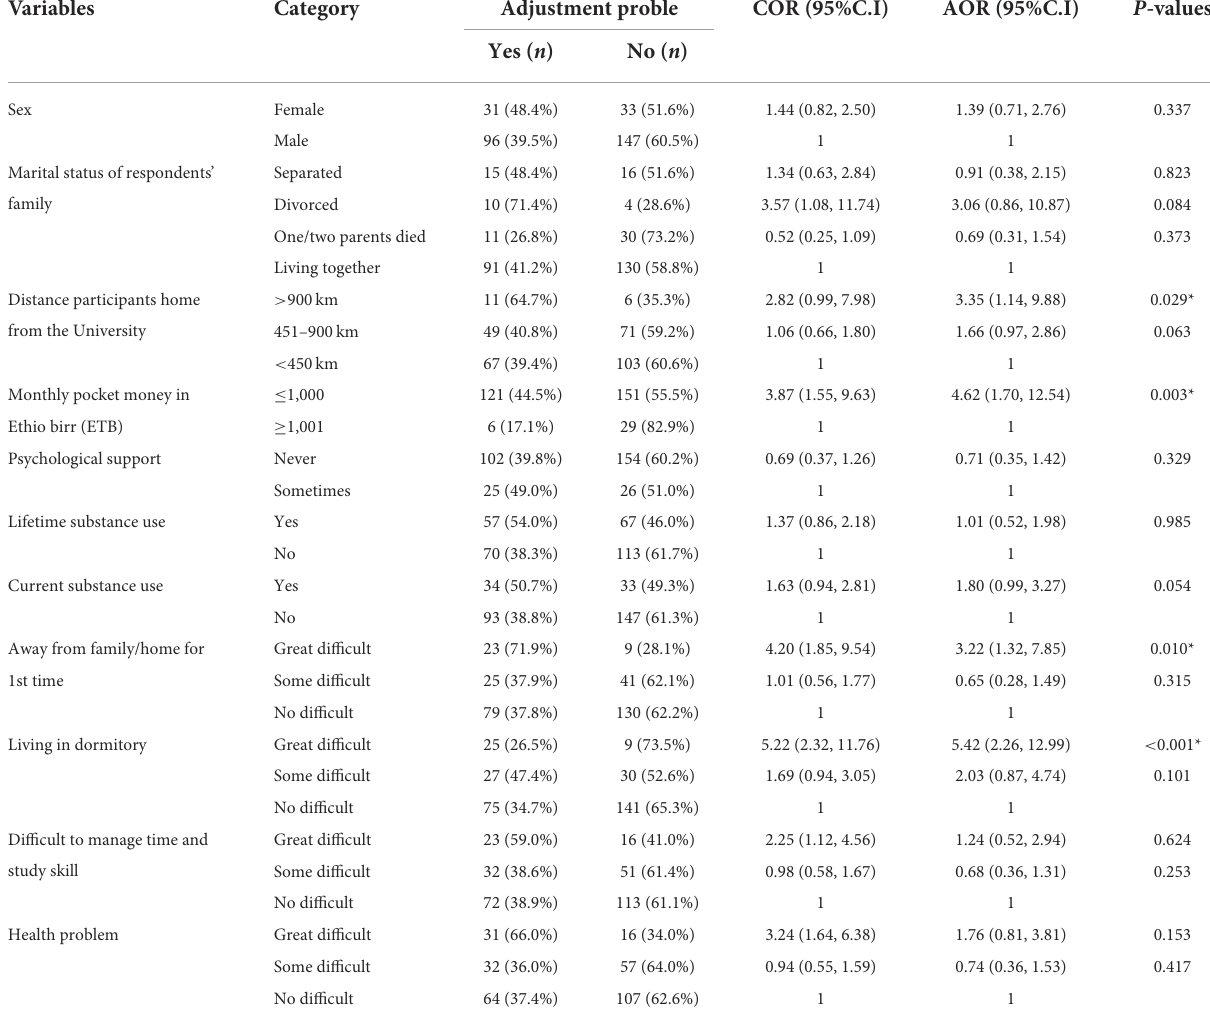
TABLE 4 Bivariate and multivariable logistic regression analysis results of adjustment problems among Wollo University main campus regular first-year undergraduates, Northeast Ethiopia, Dessie, 2020 ( n =